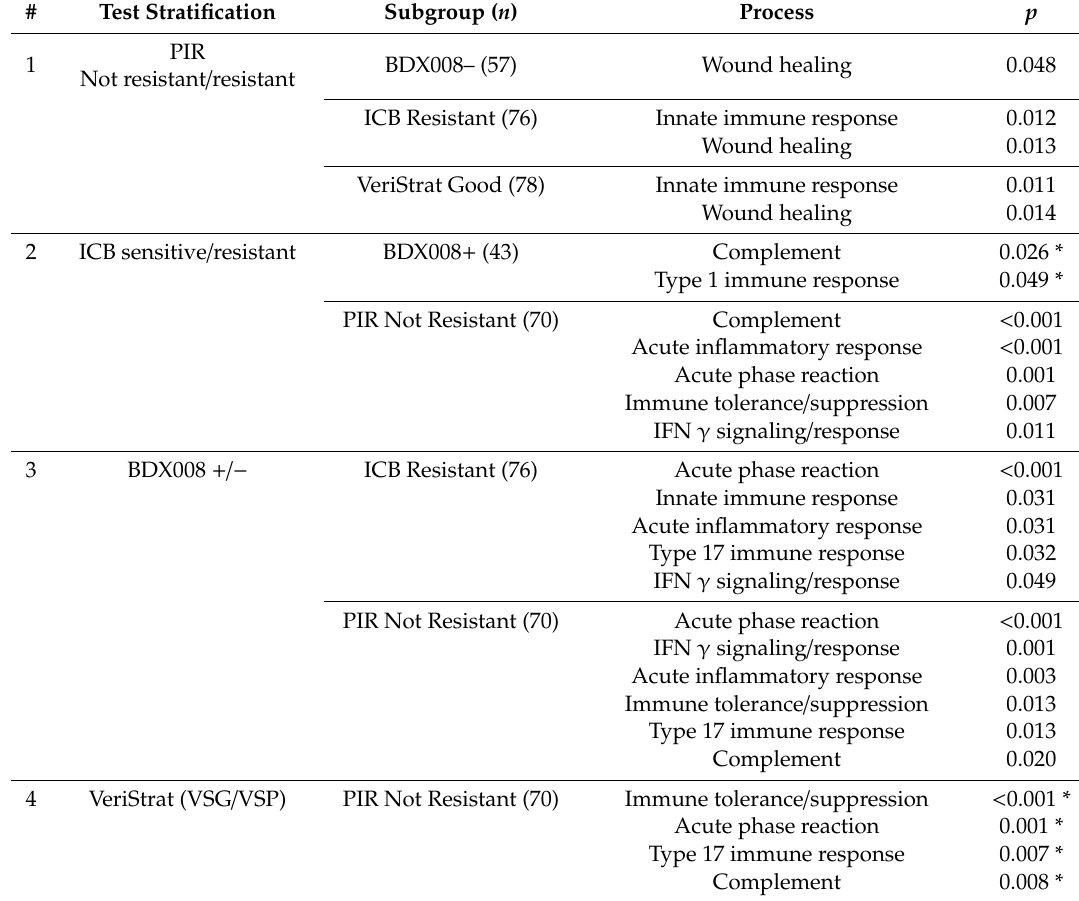
Table 5. Processes associated with the pairwise test